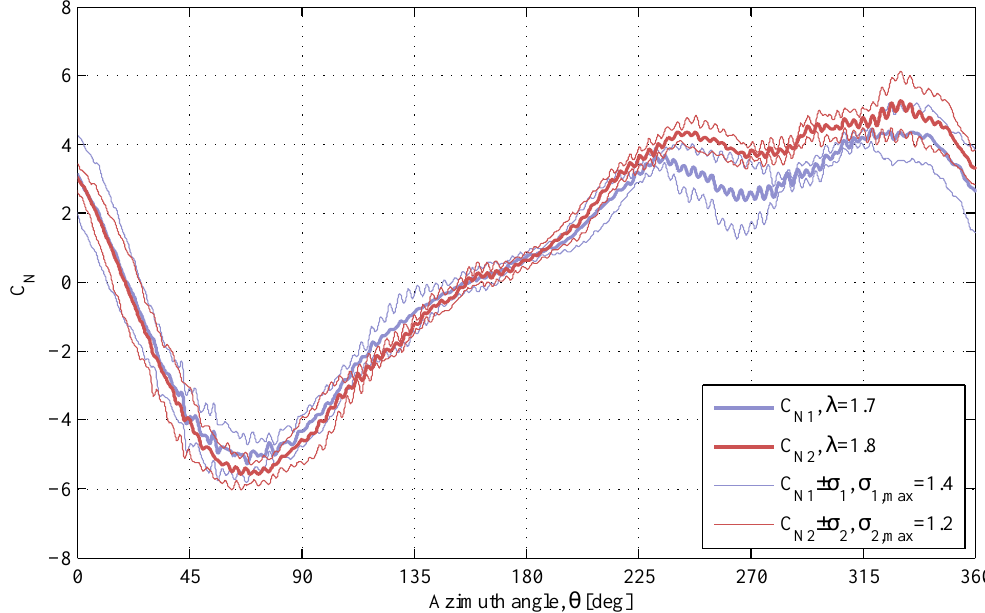
Figure 10. The average normal force coefficient at the turbine rotational speed of 40